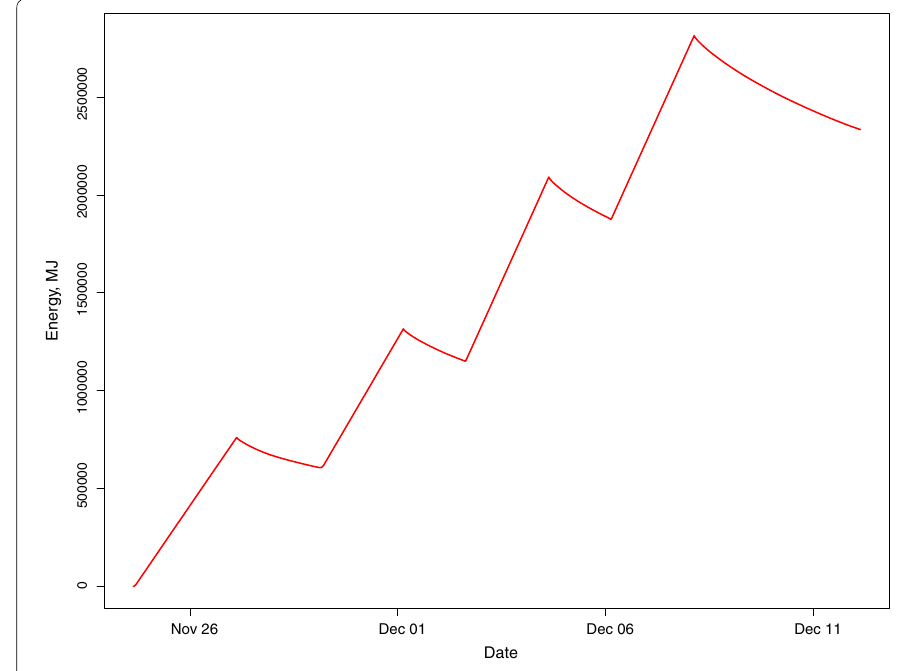
Fig. 11 Comparison of injected and recovered energy during the heat storage test